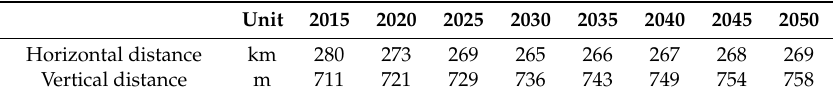
Table 9. Weighted average horizontal and vertical water pumping distances.